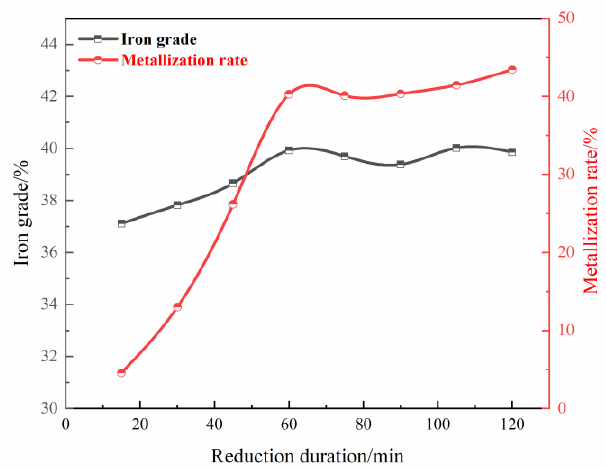
Figure 4. Effects of reduction temperature on the pre-reduction indices. (Reducing for 60 min, with a C/Fe mass ratio of 1.50, natural basicity of 0.0020).